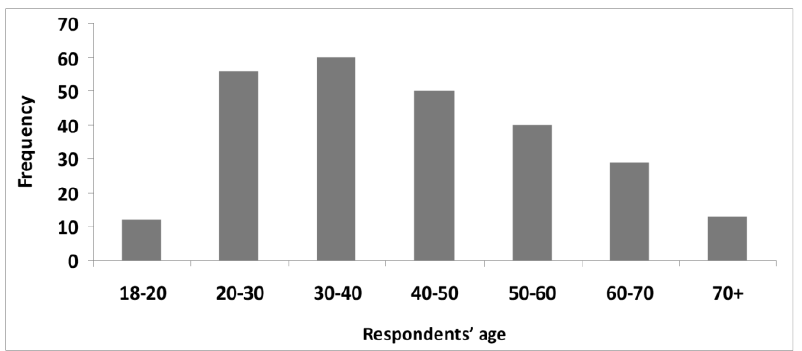
Figure 3. Respondent age structure (source: authors). Table 3 shows the respondents’ answers to the question “Please name the municipality where you currently live”. The majority of the respondents live within 50 km of the data collection